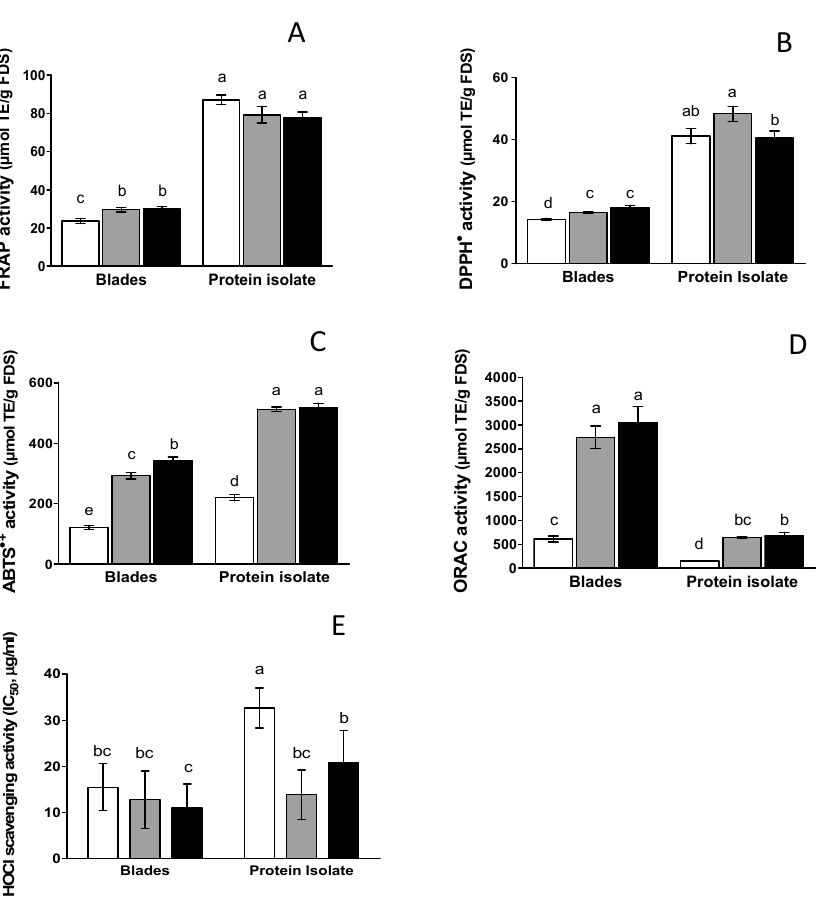
Figure 4. Ferric reducing antioxidant power (FRAP; A ), 2,2-diphenyl-1-picrylhydrazyl inhibition (DPPH · ; B ), 2,2 (cid:48) -azinobis-(3-ethylbenzothiazoline-6-sulfonate) inhibition (ABTS · + ; C ), oxygen radical absorbance capacity (ORAC; D ) and hypochlorous acid (HOCl; E ) scavenging activity of Porphyra dioica blades and protein isolate, following 2 h hydrolysis at 50 ◦ C with Prolyve ® 1000 (H-Prolyve), and 4 h with Prolyve ® 1000 plus Flavourzyme ® (H-ProFla). For FRAP, DPPH · , ABTS · + and ORAC assays, results (mean ± standard deviation; n = 3) are expressed in µ mol of Trolox equivalents (TE) per g of freeze-dried sample (FDS); HOCl scavenging capacity (mean ± standard deviation; n = 3) is expressed as IC 50 ( µ g FDS / mL extract). Within each sample, di ff erent (a, b and c) letters denote significant di ff erences between treatments at p < 0.05.